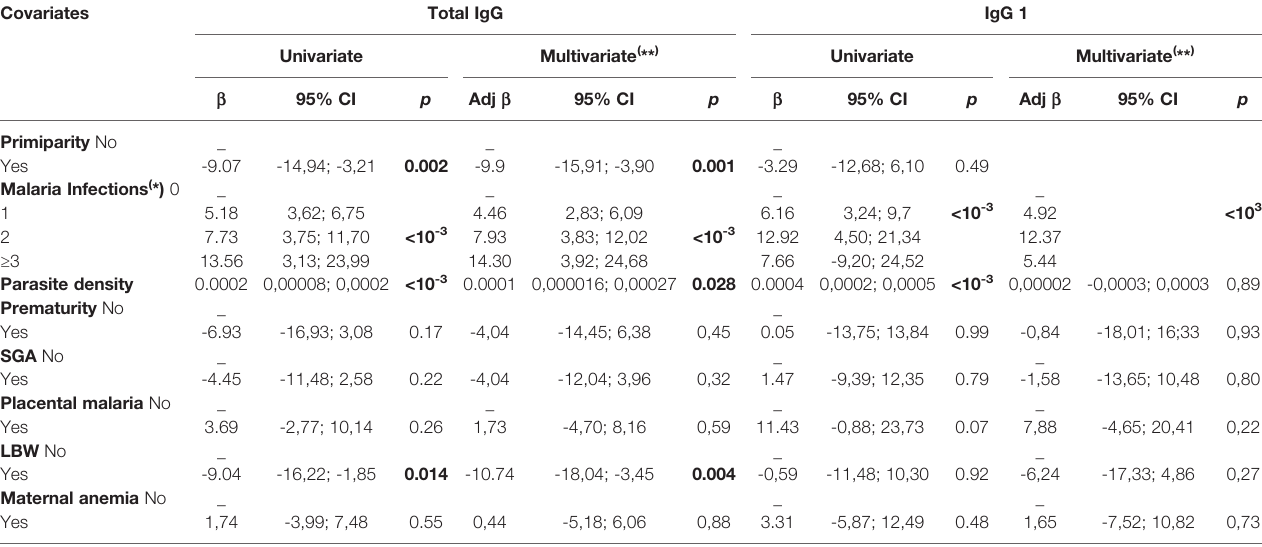
TABLE 2 | Relationship between antibody levels to ID1-ID2a construct of VAR2CSA and pregnancy outcomes (Total IgG and IgG1).